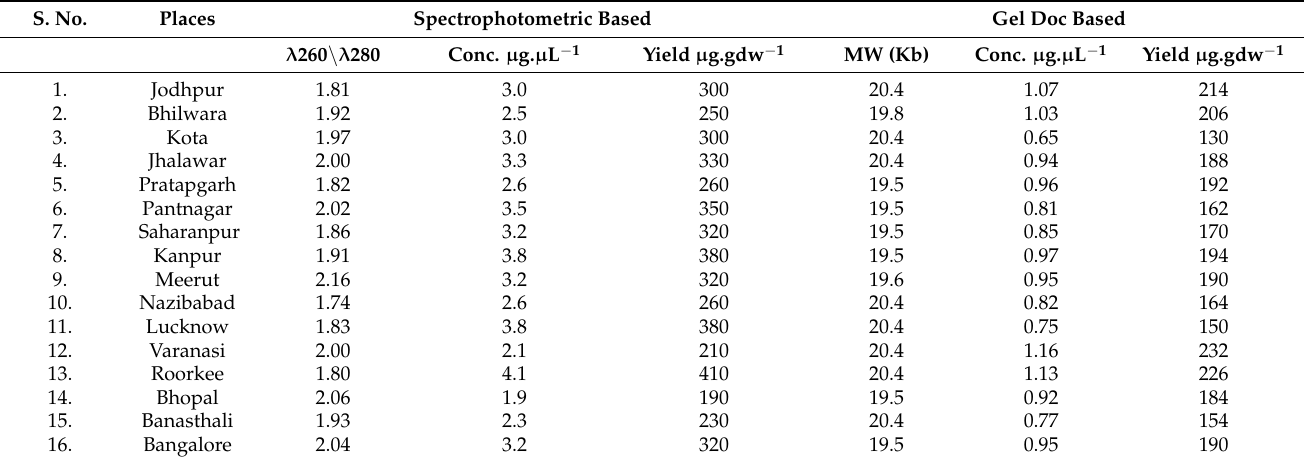
Table 3. Quantification of genomic DNA of S. cumini leaf samples collected from different places using spectrophotometer and gel documentation system.